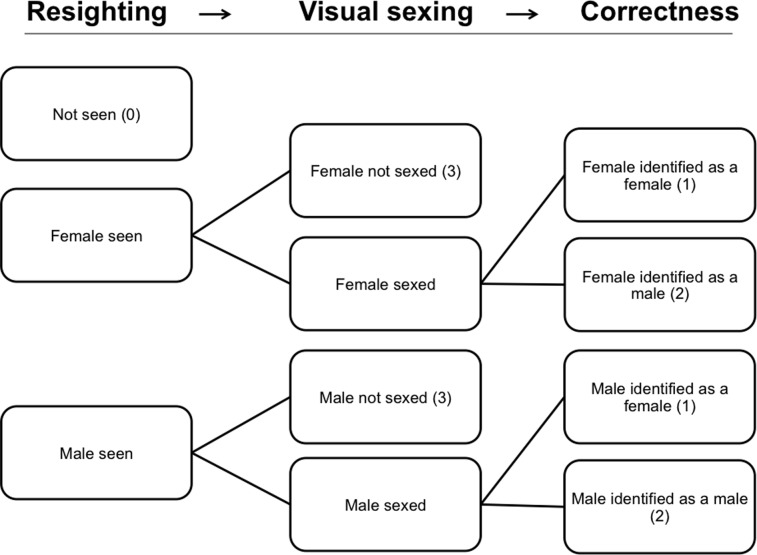
Events and underlying states.The observation process consists of three steps, each one conditional on the event in the previous step. The codes for each event as they appear in the raw data for encounter histories are given in parentheses.